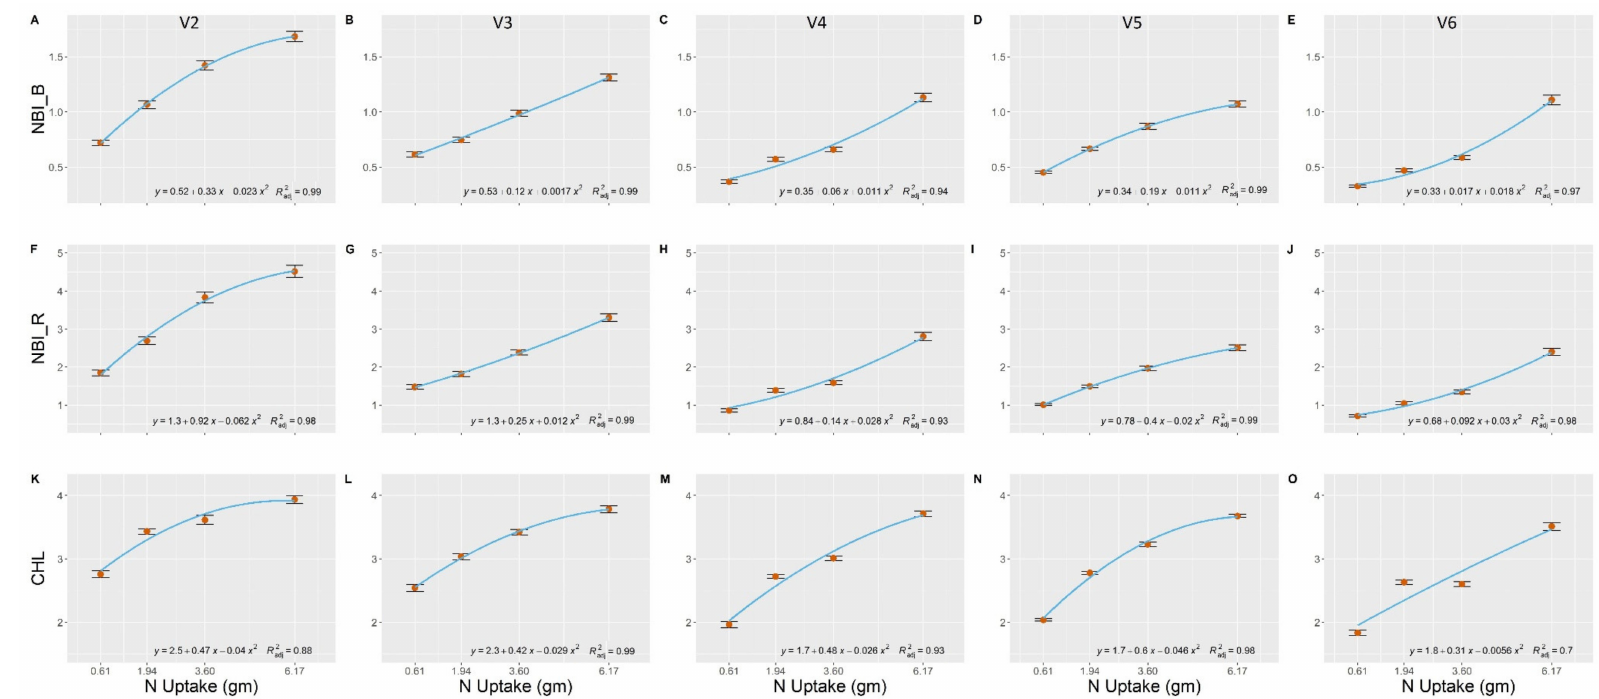
Figure 3. Fluorescence indices as a function of N uptake generated by di ff erent nutrient solutions with N variability in maize at four di ff erent crop growth stages under greenhouse conditions. V2 refers to the 10th day after emergence (DAE), and V3, V4, V5, and V6 refer to the crop growth stages at the 18th, 26th, 35th, and 38th DAE, respectively. Bars represent confidence intervals ( α = 0.05), and fitted curves are quadratic polynomials with their respective coe ffi cients of determination (R 2